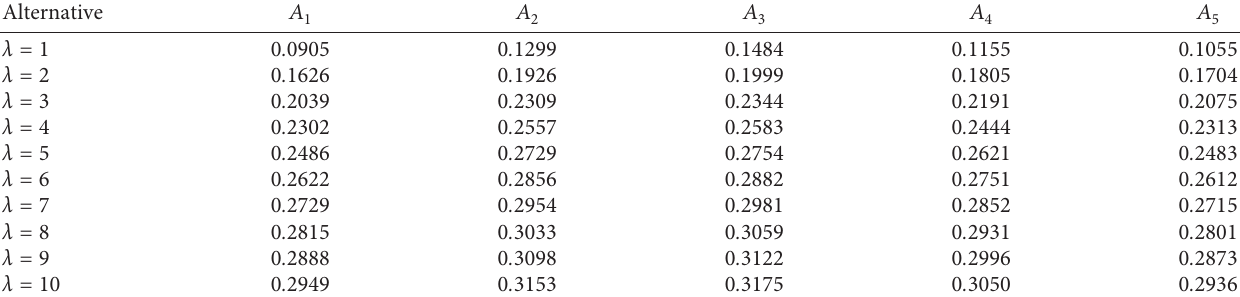
Table 12: The closeness coefficient CD